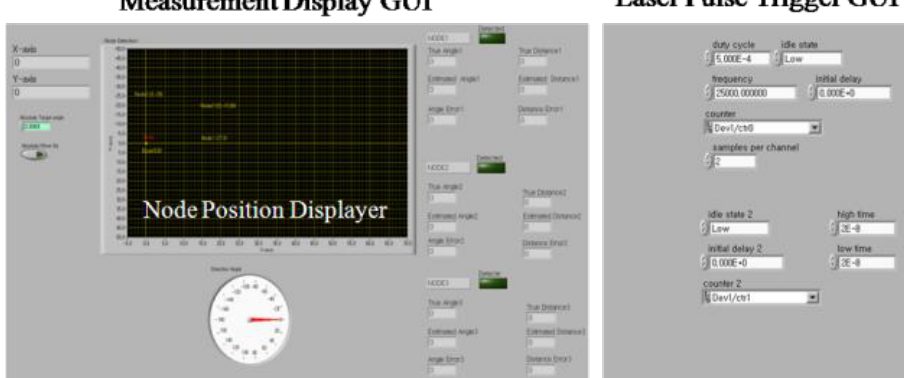
Figure 4. System